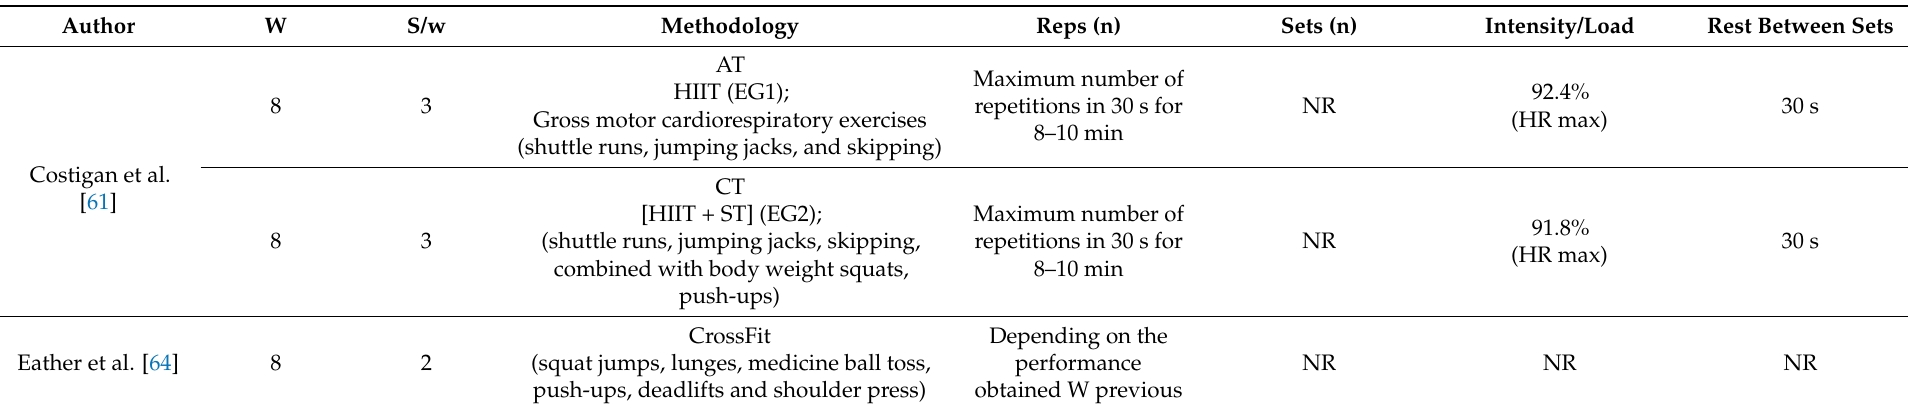
Table 2. Characteristics of Strength Training